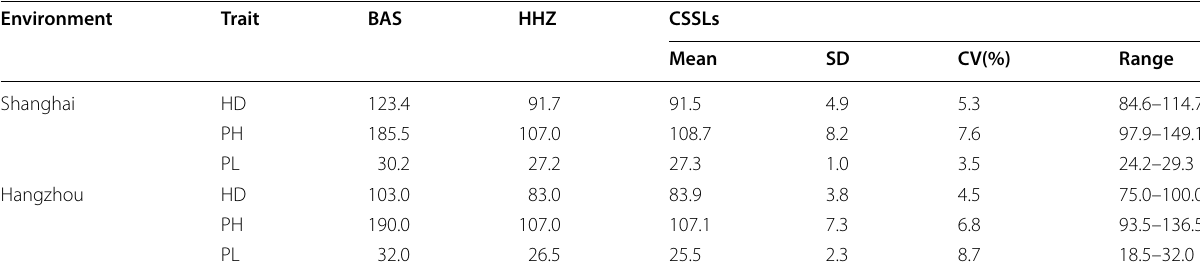
SD standard deviation; CV coefficient of variation